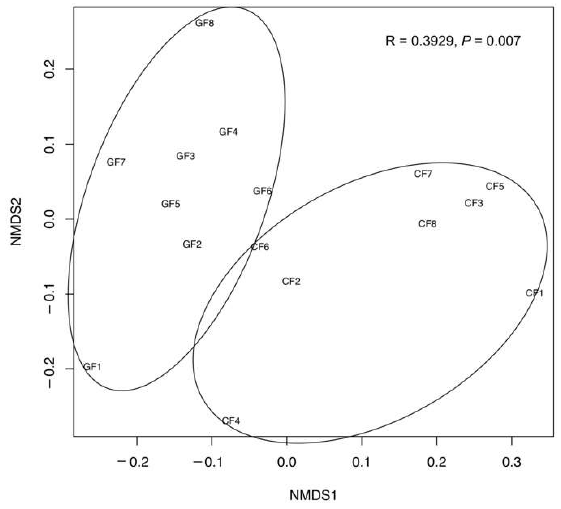
Figure 7. Non-metric multidimensional scaling (NMDS) plot visualizing bacterial functional community dissimilarities using Bray–Curtis distance.